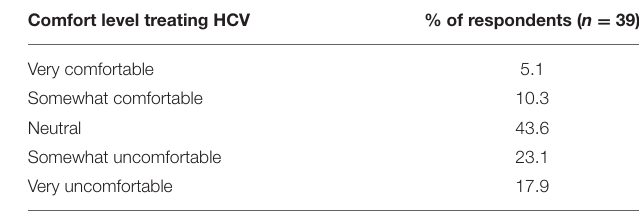
TABLE 9 | Do you feel comfortable/adequately trained in treating HCV in your facility’s HCV + patients? (China Medical Director HCV survey, 2021).